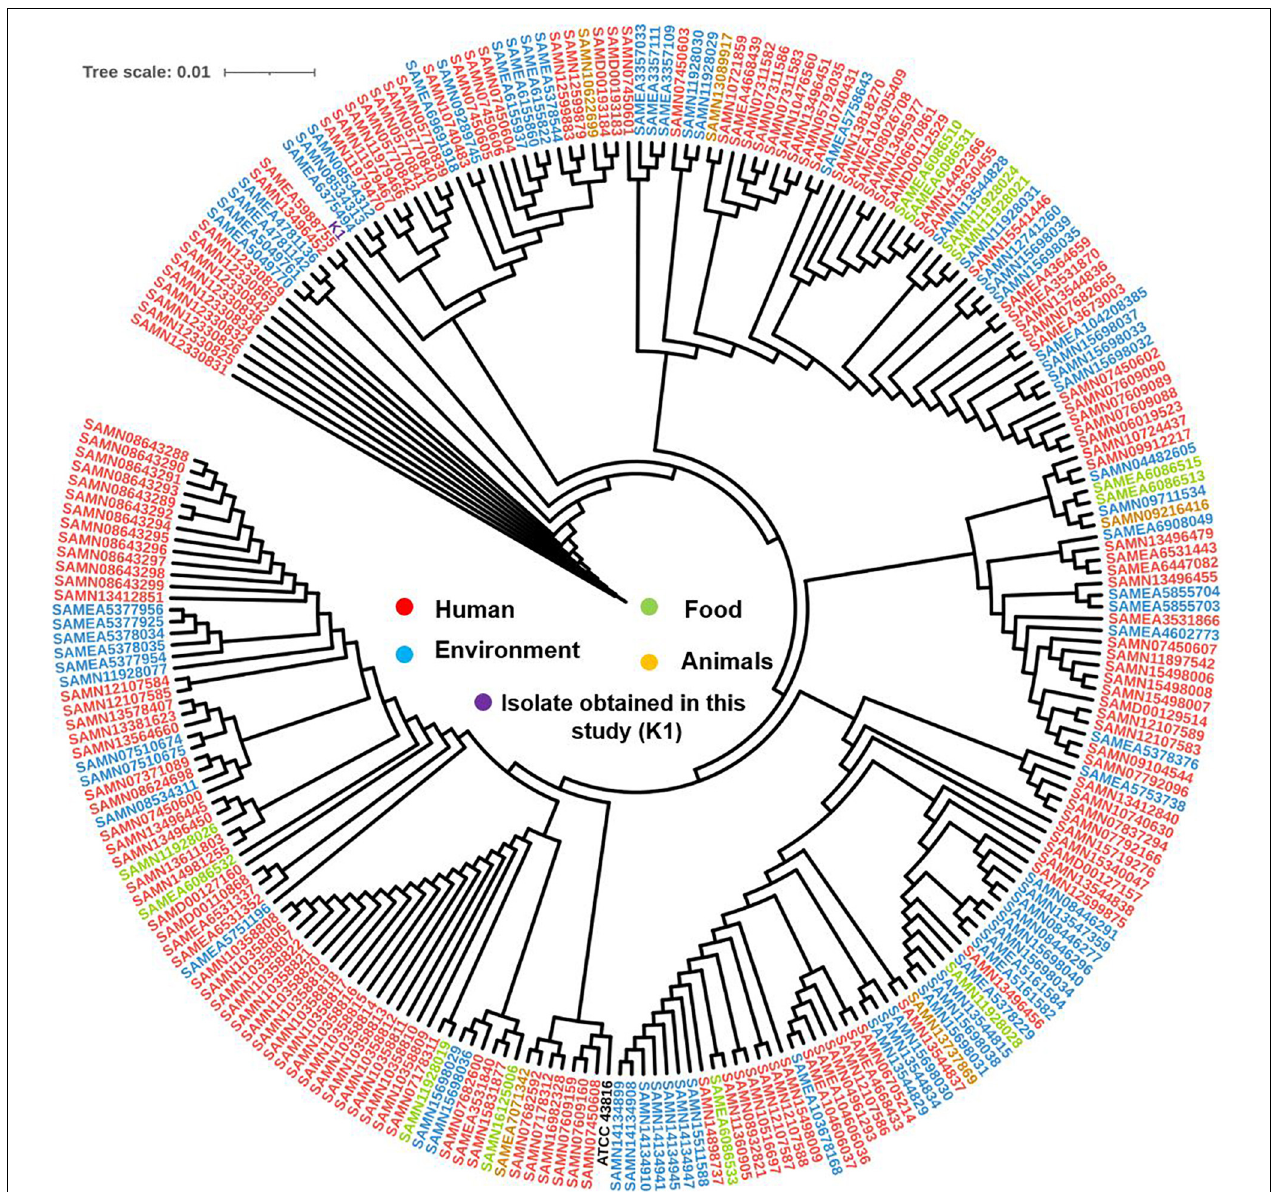
FIGURE 3 | Global phylogenomic analysis of the present study K. pneumoniae isolate (K1) and all the publicly available genomes of K. pneumoniae ( n = 241) in the NCBI database that carried any variant of mcr gene. Isolates were mapped to a reference K. pneumoniae complete genome ATCC 43816